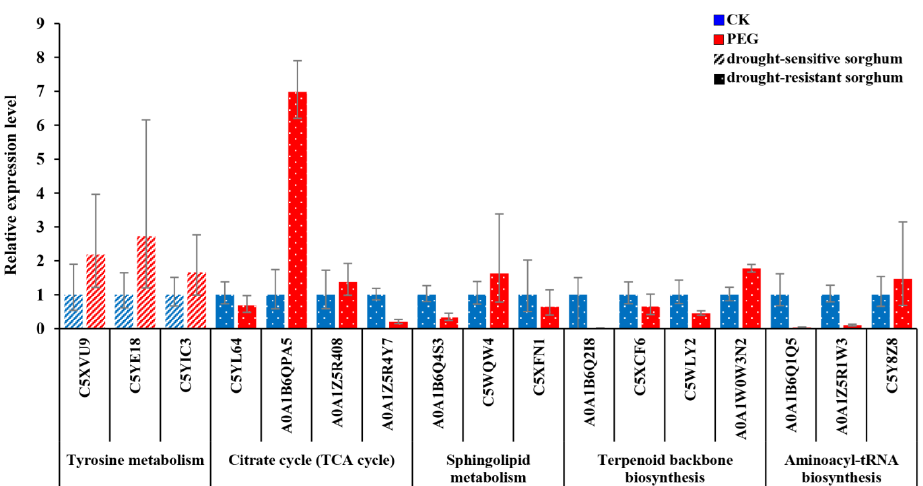
Figure 5. qRT-PCR validation of the mRNA expression profiles of 17 DAPs in drought-sensitive and drought-resistant varieties under control and PEG-stressed conditions. The average expression level in the control is set to 1. Error bars represent standard error (n = 3). C5XVU9: S-(hydroxymethyl)glu-